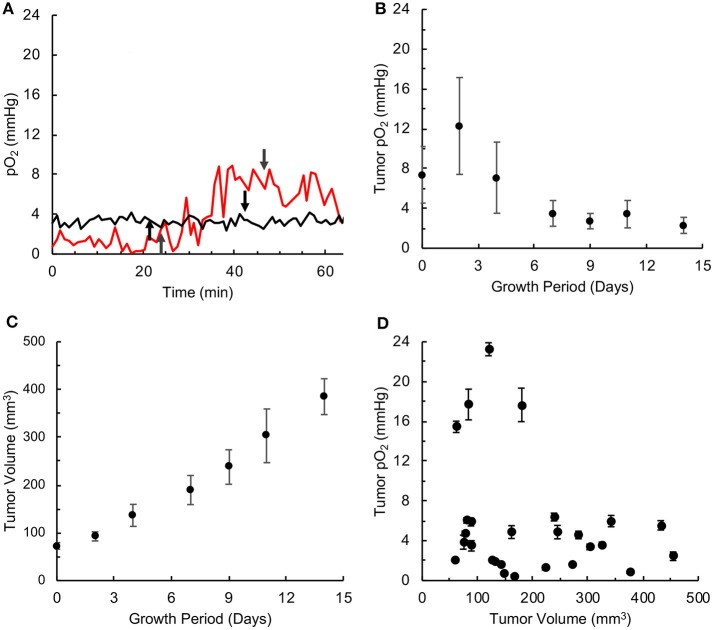
TNBC xenograft tumor is associated with severe hypoxia. Oxygen concentration (pO2) was measured by in vivo EPR oximetry in triple-negative breast cancer (TNBC) xenograft tumors, developed in mice using MDA-MB-231 cells. (A) Representative tracings of tumor pO2 values in mice breathing room air and 100% oxygen. In both cases, the mice were kept in room air for about 20 min, the breathing gas was switched to 100% oxygen at the time point indicated by the up-arrow and returned to room-air breathing 20 min later (indicated by down-arrow). In one case (red tracing), the tumor pO2 increased from about ~2 mmHg to ~8 mmHg at the end of 20 min of 100% oxygen administration, while in the other case (black tracing) the tumor oxygen was at ~4 mmHg and was non-responsive to hyperoxygen breathing. (B) Tumor pO2 values (Mean ± SEM, N = 4) measured over growth period. (C) Tumor volume (Mean ± SEM, N = 27) measured over growth period. (D) Relationship between tumor pO2 (Mean ± SEM of measurement) and volume for individual tumors. There is no correlation between tumor pO2 and volume (r = 0.269).